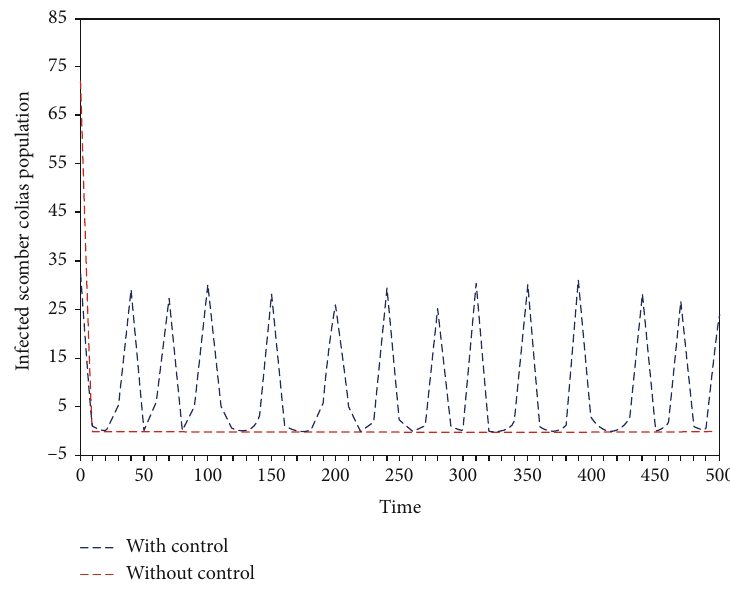
Figure 14: Infected Scomber colias population with optimal harvesting and e ff ort harvesting, with high e ff ort.